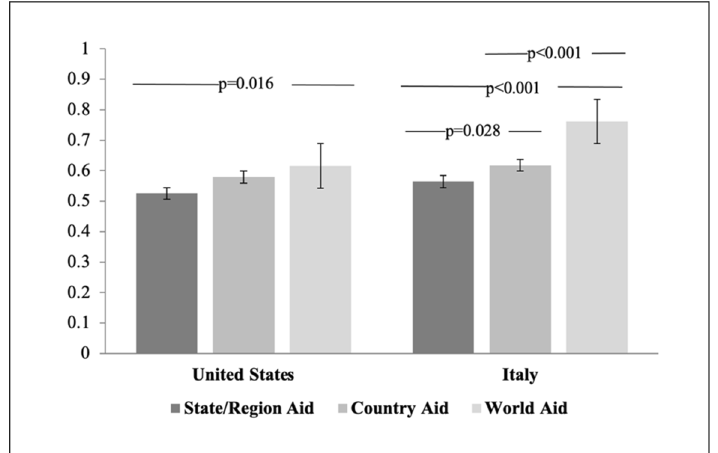
Figure 4. Conditional donations. The shares of bonus donated to a charity, conditional on donating, are plotted. The p -values report significance levels of Mann–Whitney-Wilcoxon tests on the null hypothesis that observations come from the same distribution. Whiskers indicate the confidence intervals for mean CD , obtained from bootstrapped standard errors with 10,000